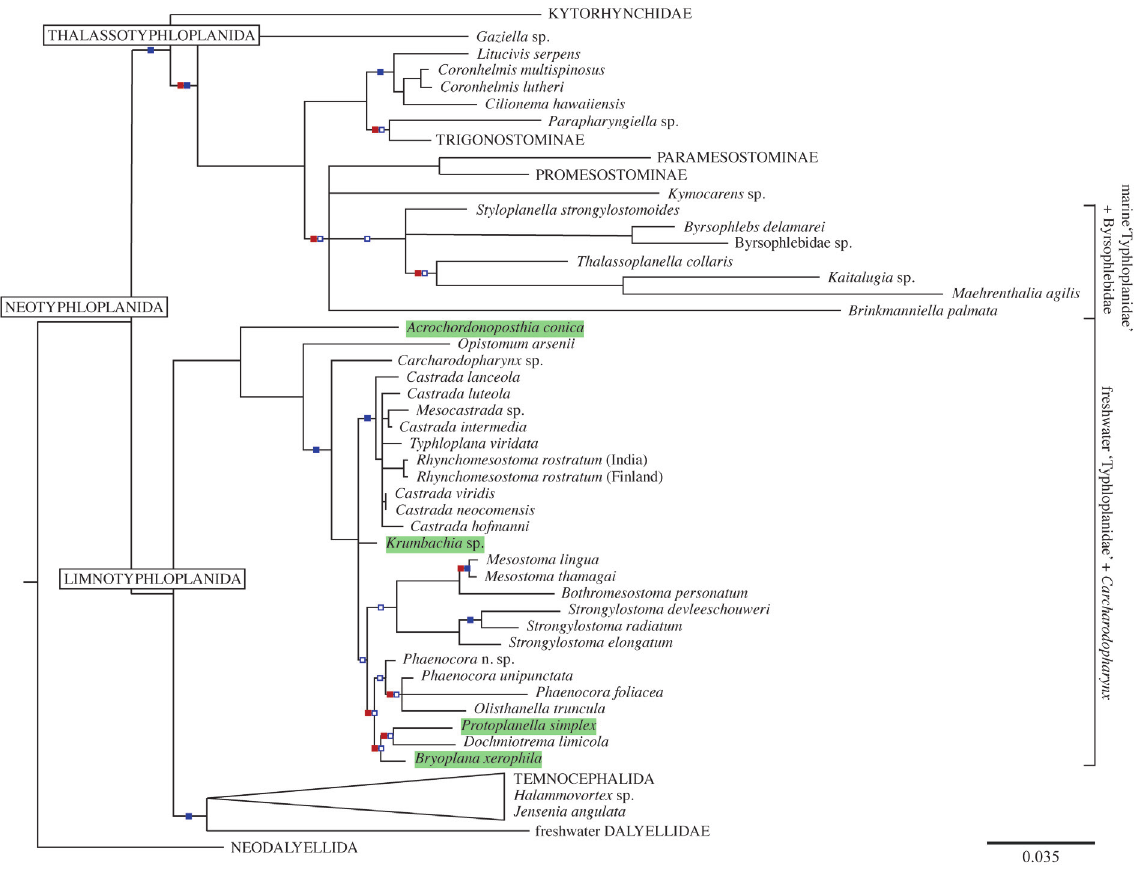
Fig. 1. Interrelationships of Dalytyphloplanida Willems, Wallberg, Jondelius, Littlewood, Backeljau, Schockaert & Artois, 2006 summarised after the maximum likelihood/Bayesian analyses of Van Steenkiste et al. (2013), demonstrating the non-monophyly of ‘Protoplanellinae’ Reisinger, 1924 and ‘Typhloplanidae’ Graff, 1905. Species traditionally ascribed to ‘Protoplanellinae’ are marked in green. Clades with bootstrap values (bp) and posterior probabilities (pp) below threshold have been collapsed (bp < 70, pp < 0.90). Symbols on branches denote support values: ■ = 0.90 < pp < 1; □ = pp < 0.90; ■ = 100 < bp < 70; □ = bp < 70. Unmarked branches indicate a maximally supported clade. Branch lengths denote the number of nucleotide substitutions per